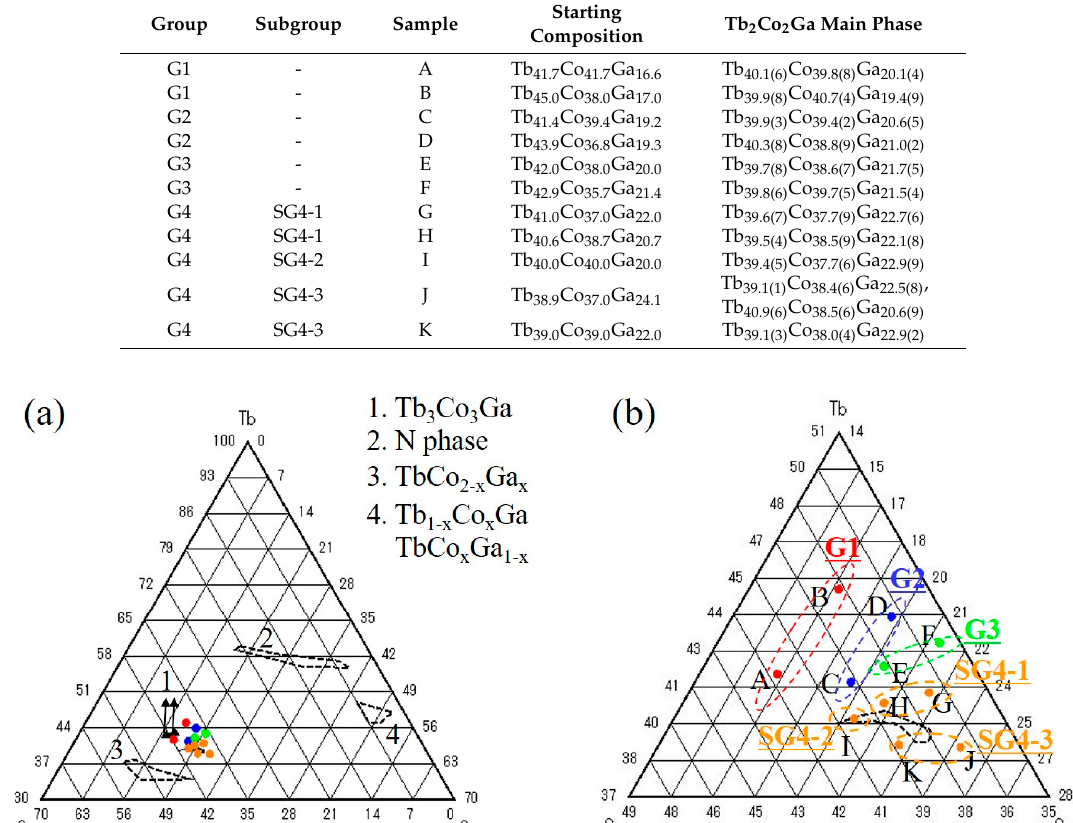
Table 1. Starting atomic compositions and determined compositions of the main phase by EDX measurement for prepared samples.